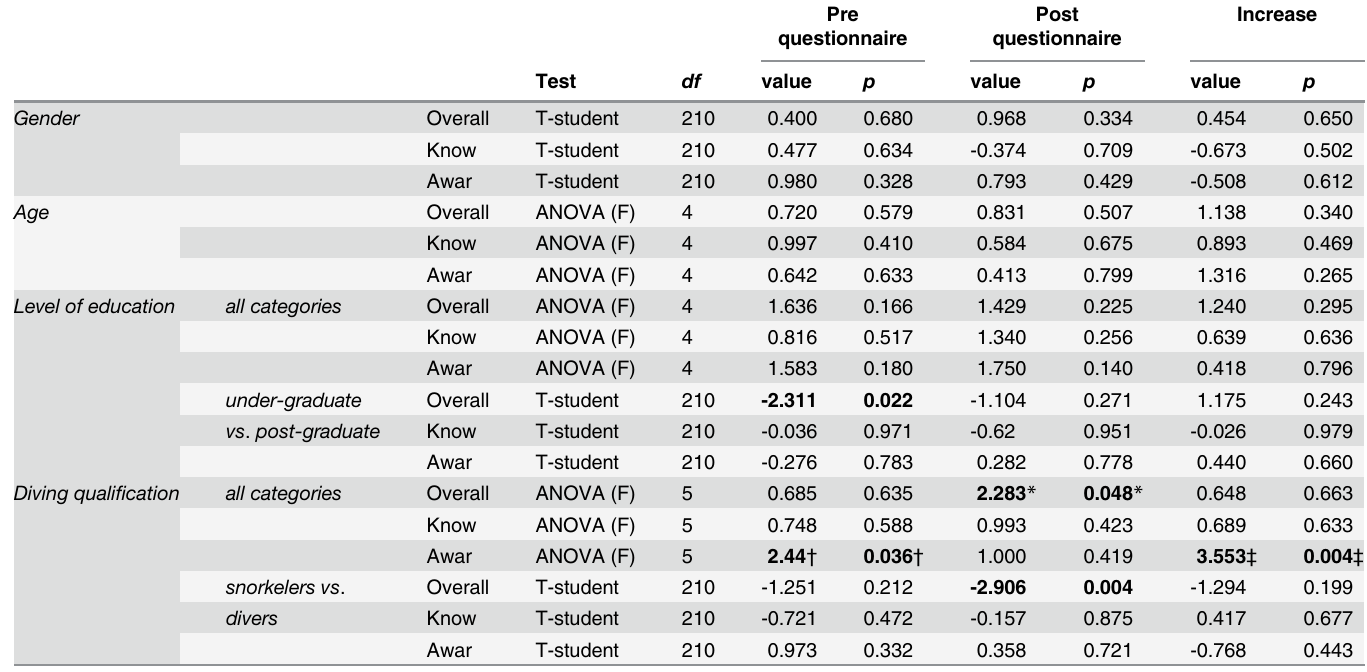
Table 3. Results of T student test or ANOVA test among the categories and groups for the mean score of the overall questionnaire, for the reef biol- ogy and the human impact questions, in the pre-, in the post-questionnaire and the its increase between the pre- and the post-questionnaire. Pre